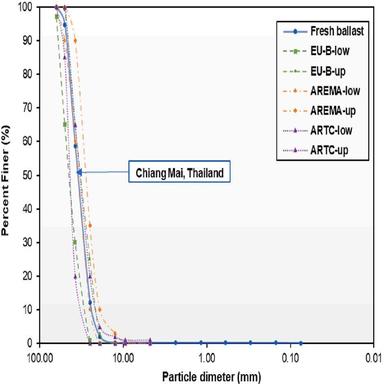
Gradation properties of ballast material.